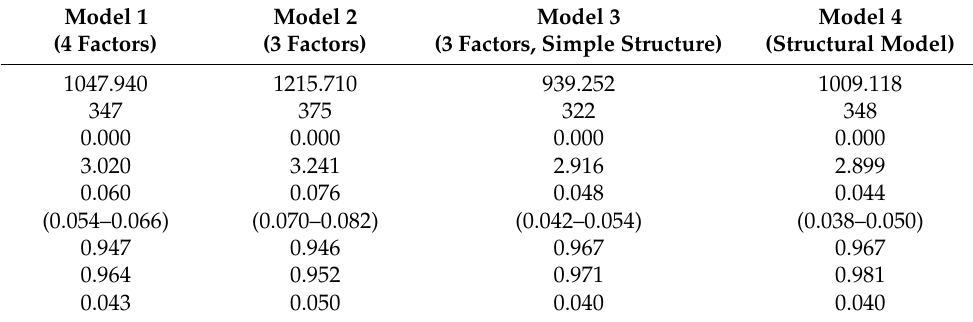
Table 3. Model fit indices.